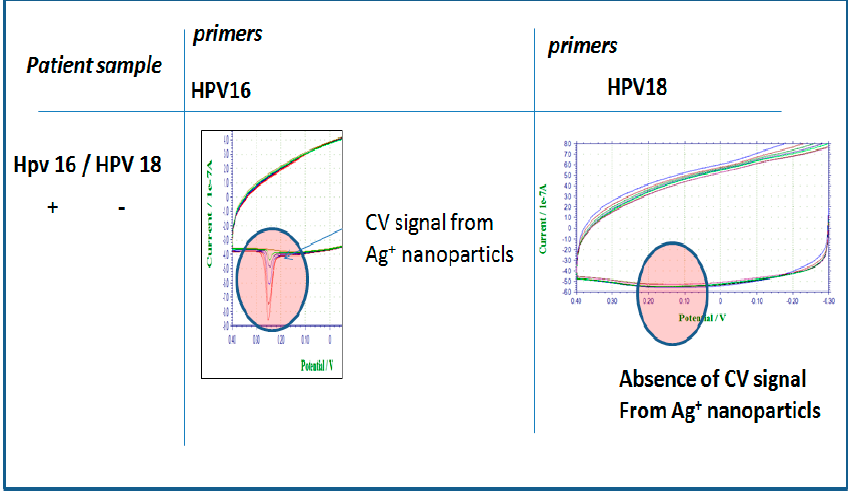
Figure 4. Electrochemical Detection of HPV with opposite Ag bonded HPV